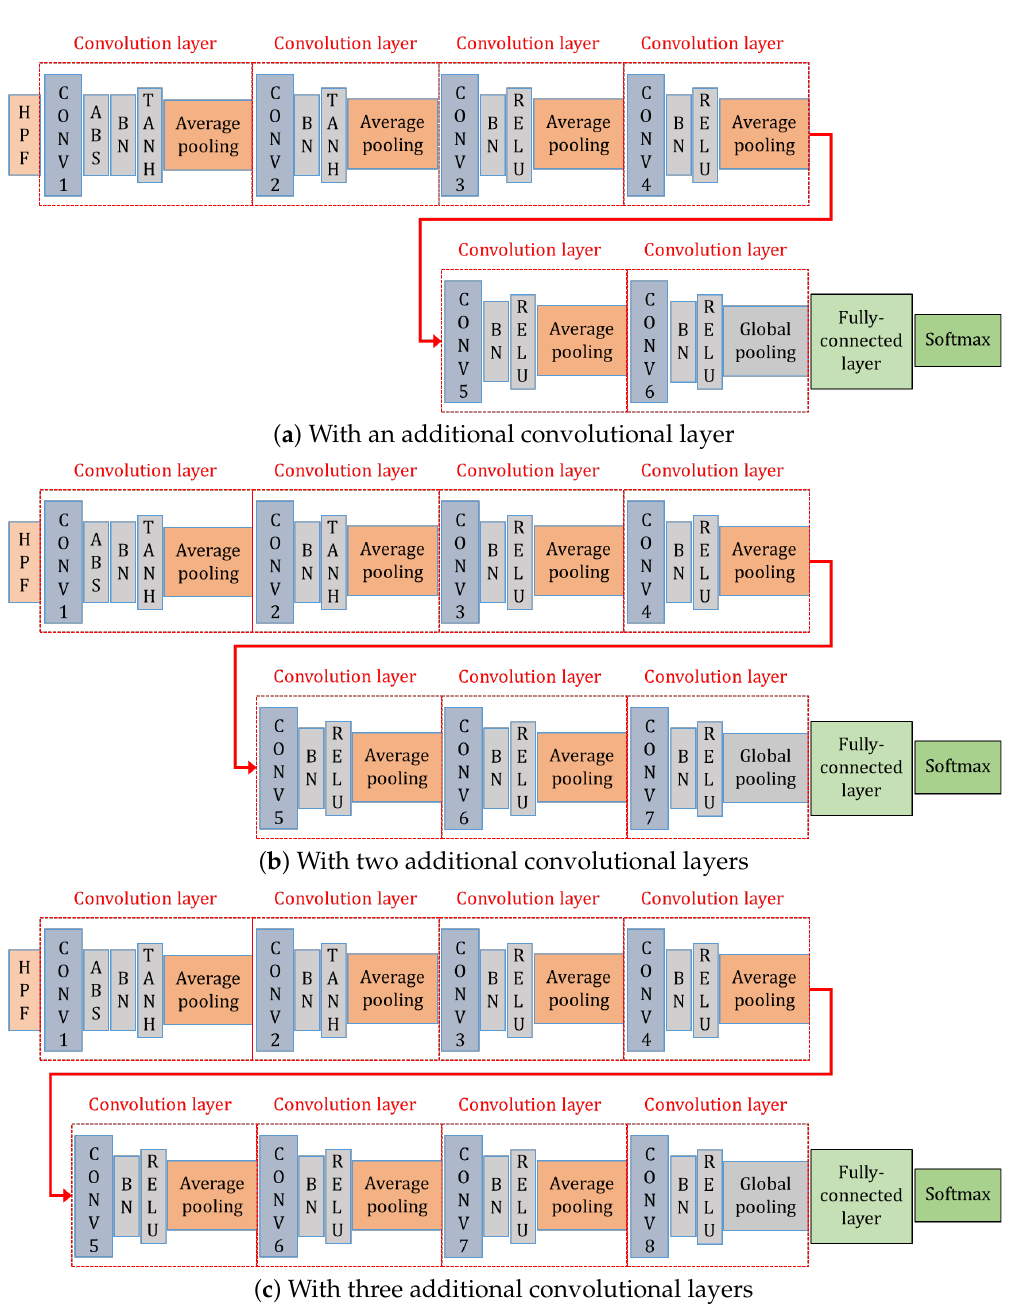
Figure 11. Extending the conventional network [17] with additional convolutional